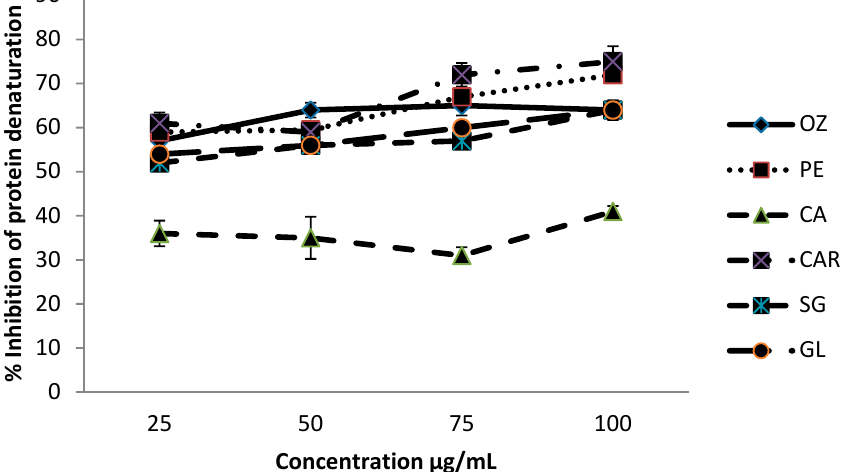
Figure 2. Effects of six green leafy vegetables on protein denaturation. Values represent means of triplicate readings. CAR— C. auriculata ; GL— G. lactiferum ; OZ— O. zeylanica ; PE— P. edulis ; CA— C. asiatica ; SG— S. grandiflora . Data are presented as the means ± standard deviations of three replicate determinations.